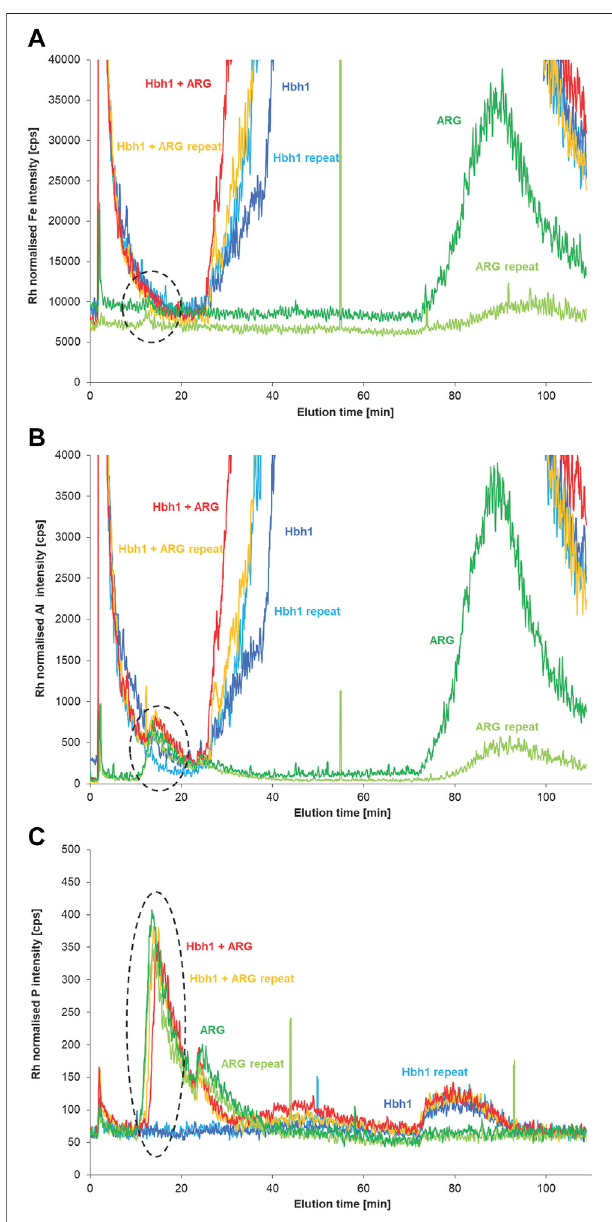
FIGURE 7 | AF4 fractograms of the natural water sample (Hbh1), the samplespikedwitheARGfragmentof530 kDa,andthefragmentindeionized water monitoring Fe (A) , Al (B) , and P (C) by ICP-MS ( n = 2).